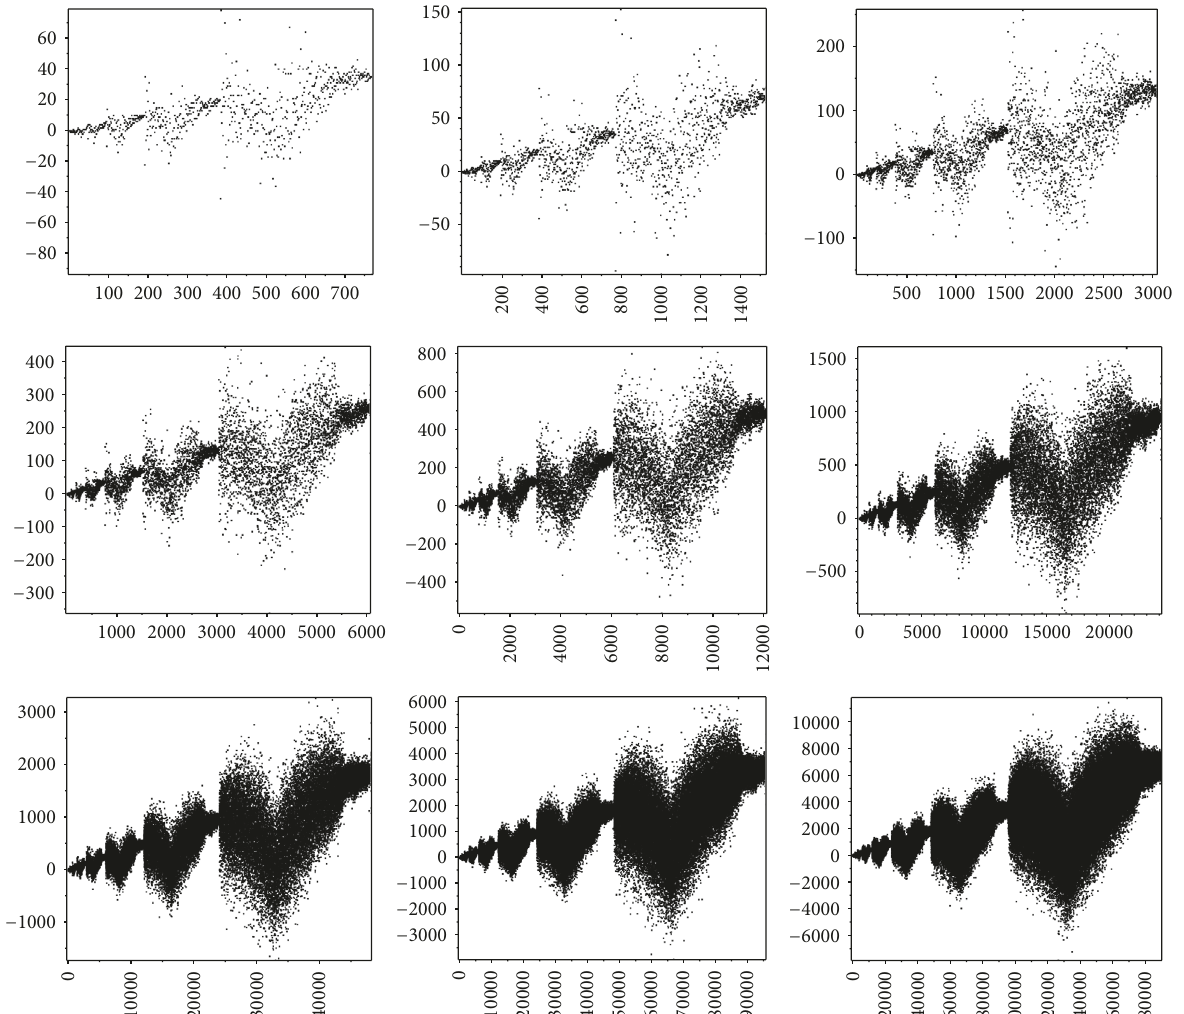
Figure 4: Hofstadter Chaotic Heart sequence for increasing values of 𝑘 (generation